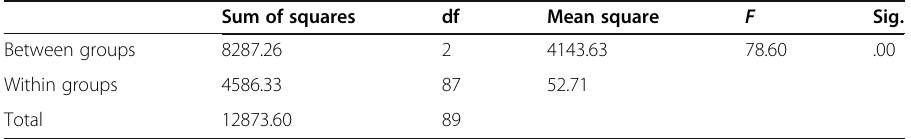
Table 4 Results of one-way ANOVA for comparing the speaking accuracy post-test scores of the GDA, C-DA, and N-DA learners Sum of squares df Sig. Between groups